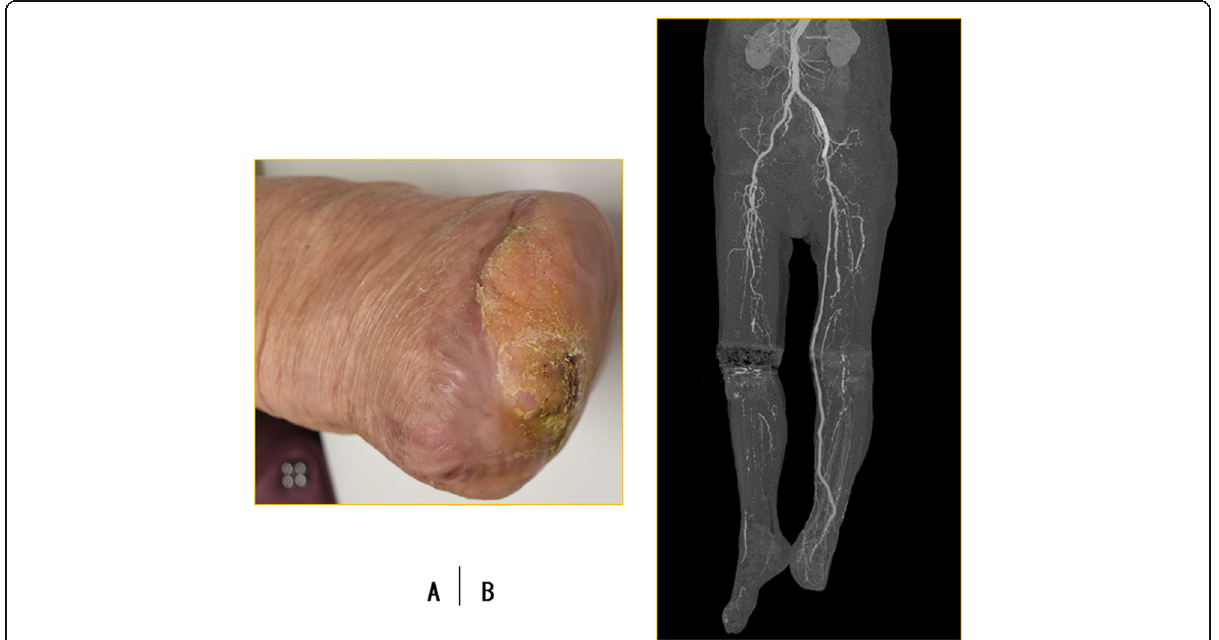
Fig. 3 The stump of the amputated toes completely healed ( a , 6 months after the bypass surgery). Follow-up contrast-enhanced computed tomography revealed that there were no complications, such as occlusion or aneurysm, of the varicose vein graft ( b